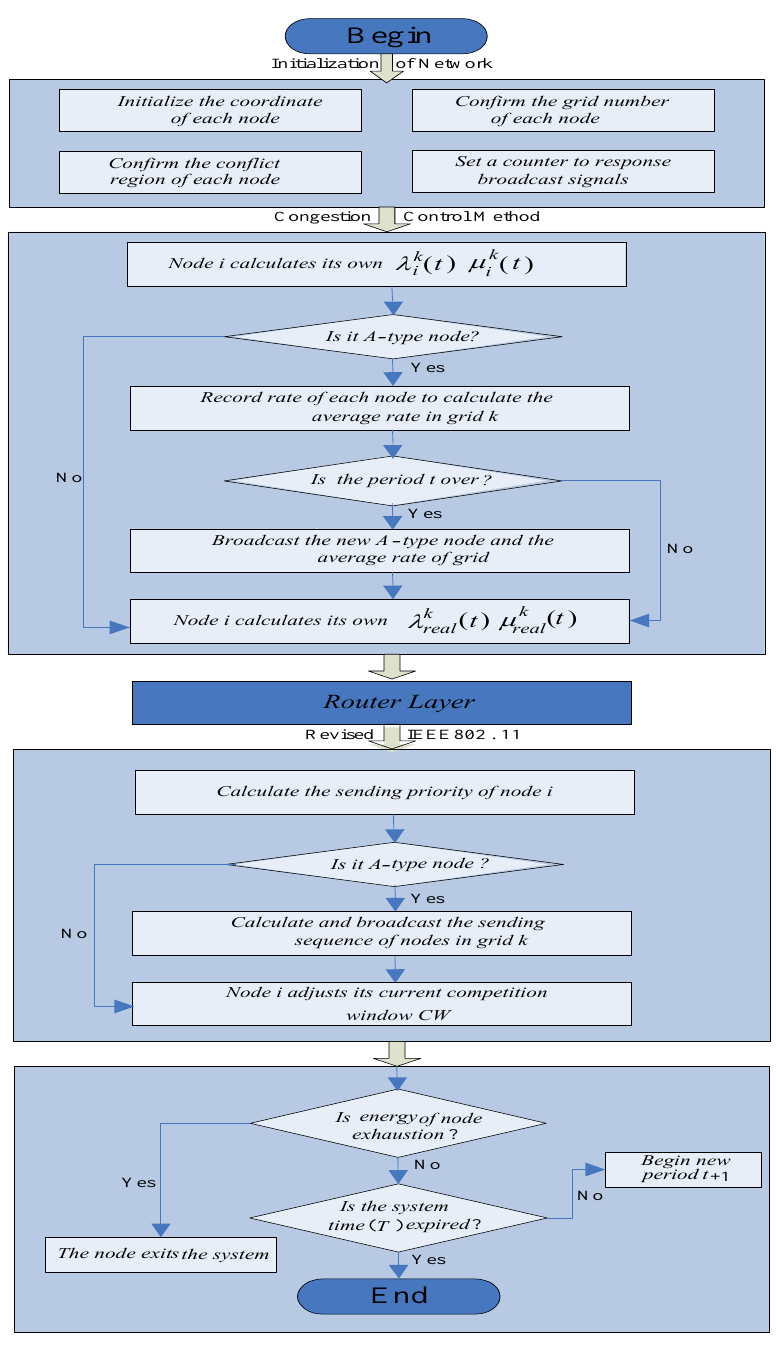
Figure 2. The data flow in the